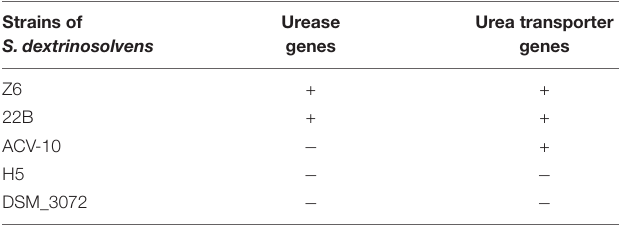
TABLE 2 | The comparison between Succinivibrio dextrinosolvens strains in urease subunit and urea transporter genes. Strains of